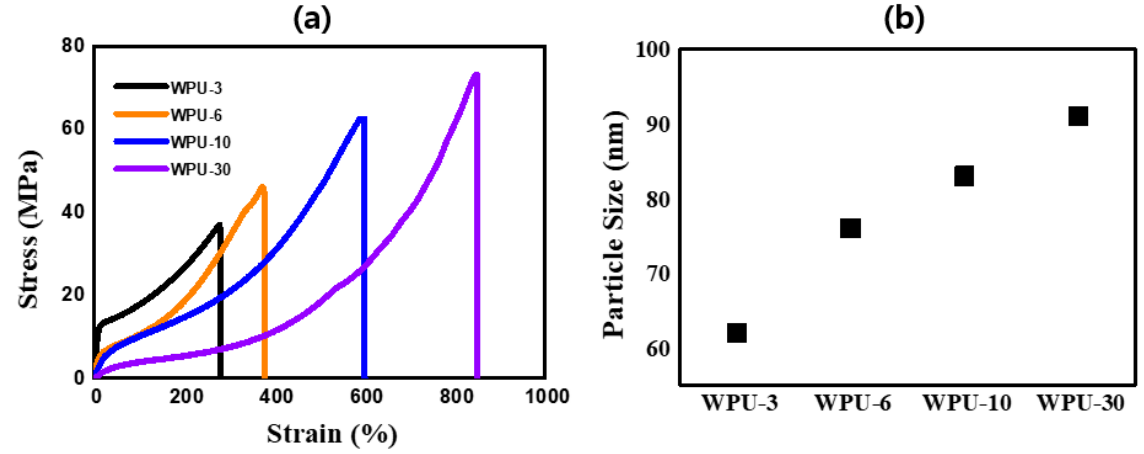
Figure 1. ( a ) Universal testing machine (UTM) measurement result. ( b ) Particle Size of WPUs.